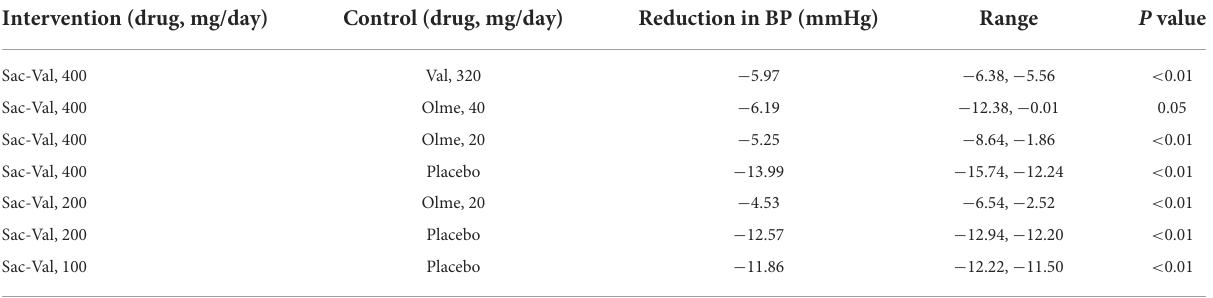
TABLE 3 Reduction in blood pressure of sacubitril-valsartan compared with other agents.